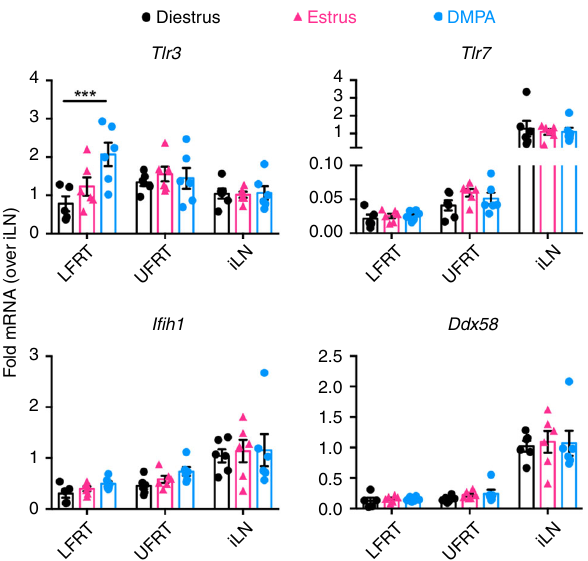
Fig. 5 Expression of RNA sensors in DMPA-treated versus naturally cycling mice. Tissues were collected from C57BL/6N female mice one week after DMPA treatment (1.0 mg/mouse), or immediately after determining the estrus or diestrus cycle by visual monitoring of in fl ammation followed by microscopic con fi rmation of cells in the vaginal lavage. Using qRT-PCR, levels of mRNA of indicated genes in all tissues were detected, normalized to GAPDH and expressed as fold-change over iLN samples within each group. Data represent mean ± SEM; n = 6 mice per group, except n = 5 in LFRT diestrus; *** p < 0.001; two-way ANOVA with Dunnett ’ s multiple comparison test. Each dot represents value from one animal. iLN, iliac lymph node; LFRT, lower female reproductive tract; UFRT, upper female reproductive tract. Source data for Fig. 5 are provided as a Source Data fi